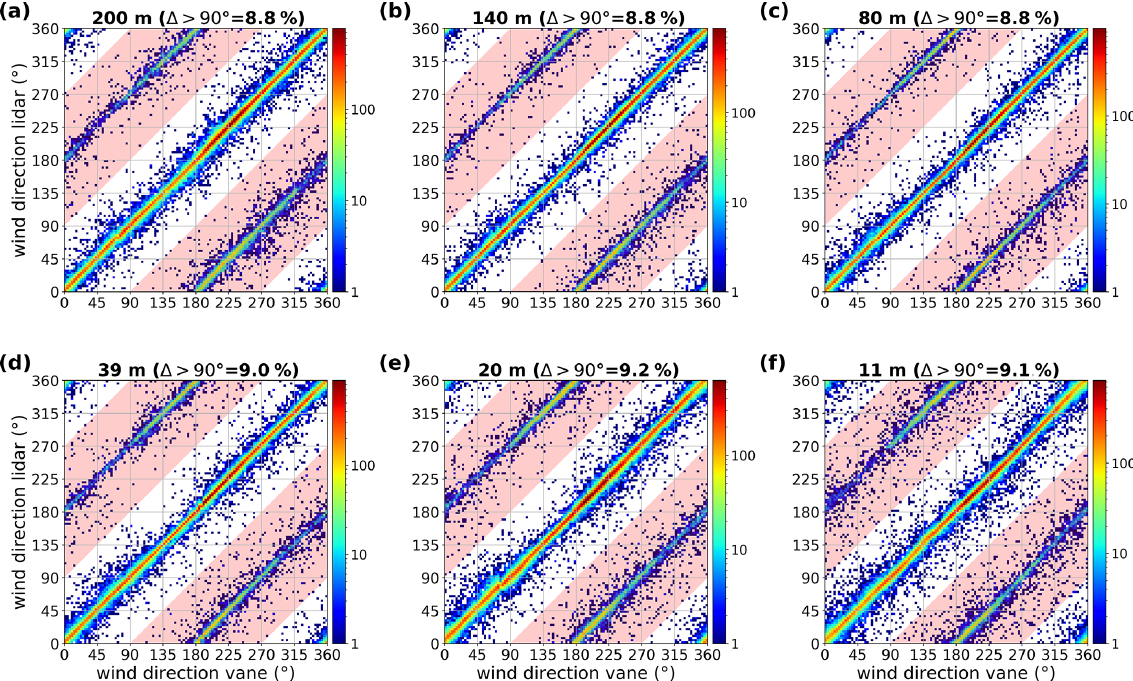
Figure 13. Wind direction comparison between wind lidar and mast data for the different heights: (a) 200m, (b) 140m, (c) 80m, (d) 39m, (e) 20m and (f) 11m. Compared to Fig. 11, here all wind directions at the 20m level are included. The regions of incorrectly assigned wind direction are indicated in red; the percentages of data in those areas are indicated at the top of each panel.